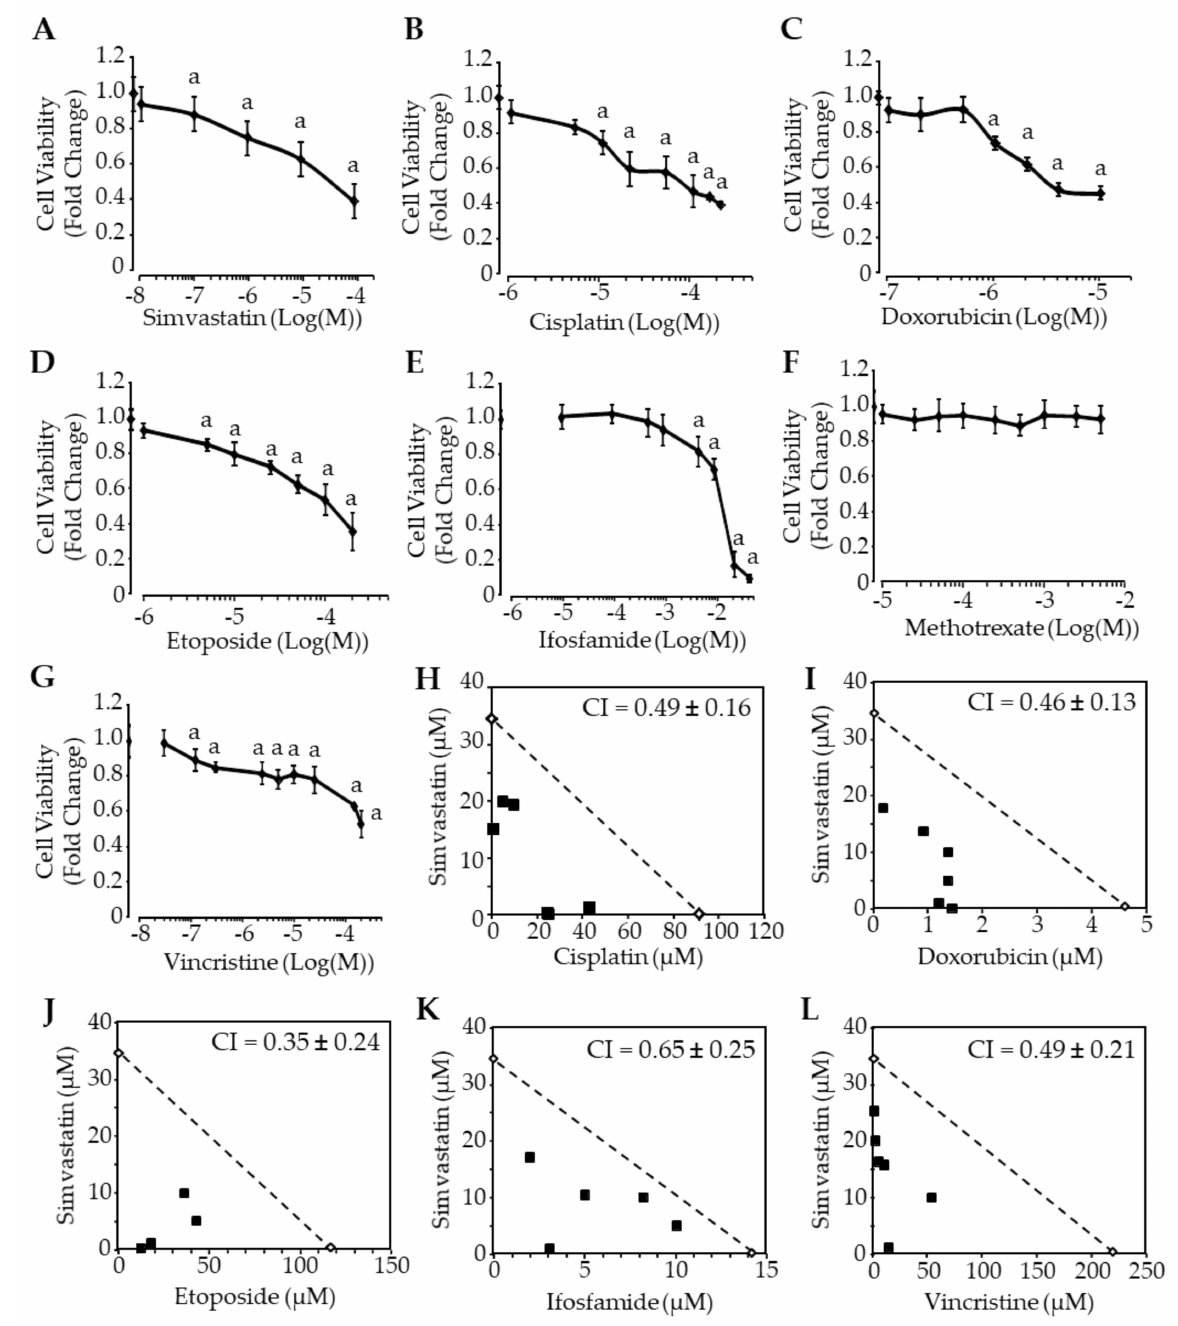
Figure 2. Chemotherapy drugs and simvastatin synergistically reduce osteosarcoma cell viability in vitro. ( A – G ) Concentra- tion-dependent cytotoxicity of conventional chemotherapy drugs and simvastatin. Murine osteosarcoma cells K7M2 were exposed to increasing concentrations of the indicated compounds for 24 h. Cell viability was evaluated by the MTT test. Results are expressed as mean ± SD ( n = 6–8) of four independent experiments. a: p < 0.05 compared to solvent. ( H – L ) Isobologram analyses of agent combination. Cells were exposed to agent alone (IC 50 ) or in combination (at various fixed concentration ratios) for 24 h. Cell viability was evaluated by the MTT test to determine the IC 50 values of the different combinations. The isobole (dotted) line represents the expected additive effect when there is no interaction between the drugs. The combination index (CI) was determined as described in the Materials and Methods